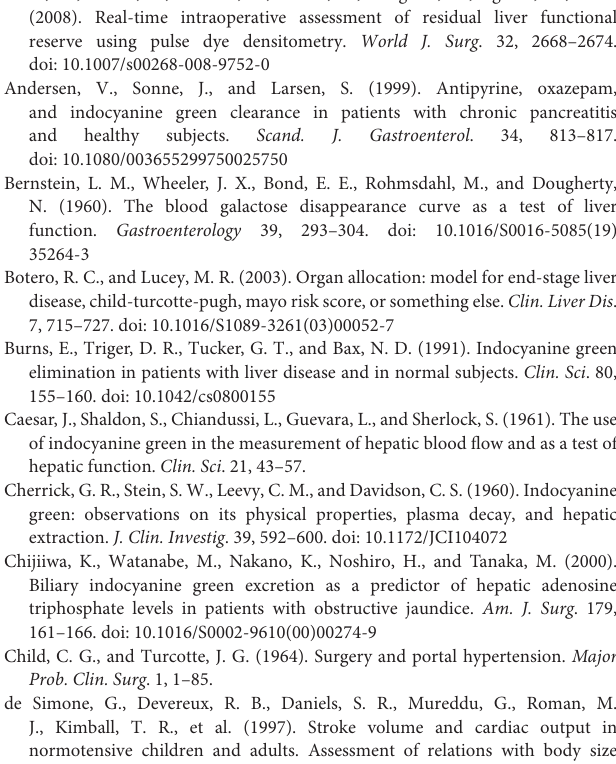
comparison of indocyanine green retention test with the cirrhotic severity